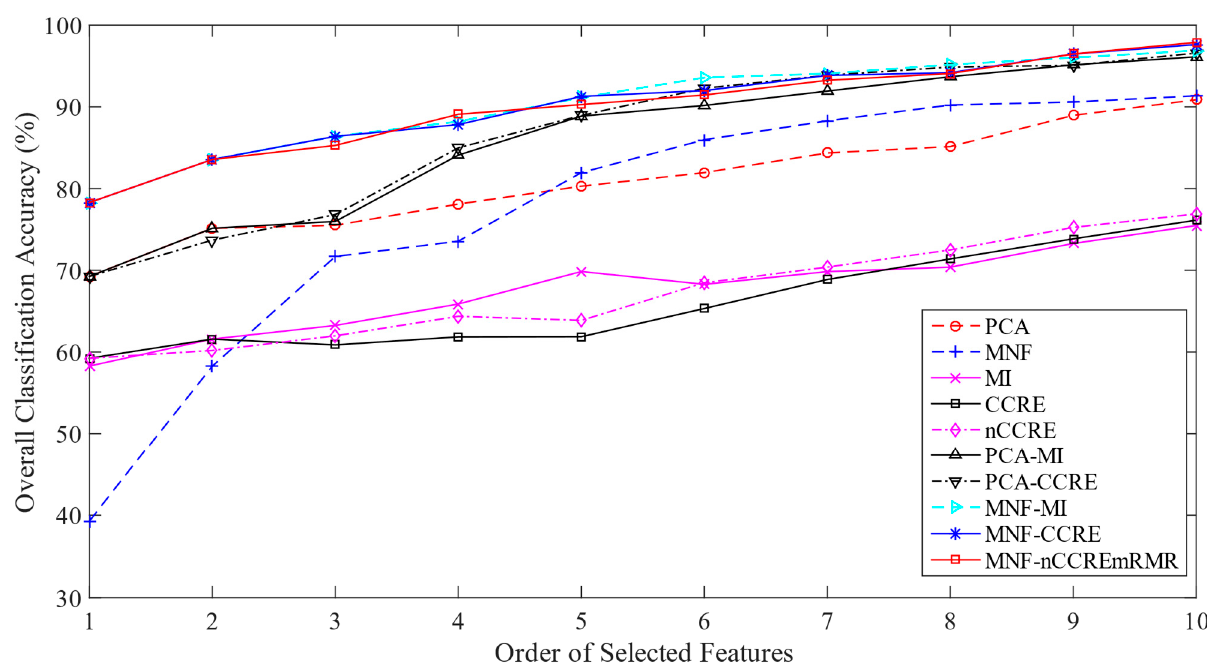
Figure 8. Overall classification accuracy versus features for the ROSIS PU dataset. We next calculated the OA on the three datasets in various numbers of training and testing ratios to confirm the robustness of the suggested feature extraction techniques in comparison to the investigated state-of-the-art feature reduction techniques. Table 12 shows the OA of the three datasets in 10%, 20%, and 30% of training samples. The results also reveal that the proposed method for feature extraction was better that the investigated state-of-the-art feature reduction methods for each of the three HSI datasets. On the